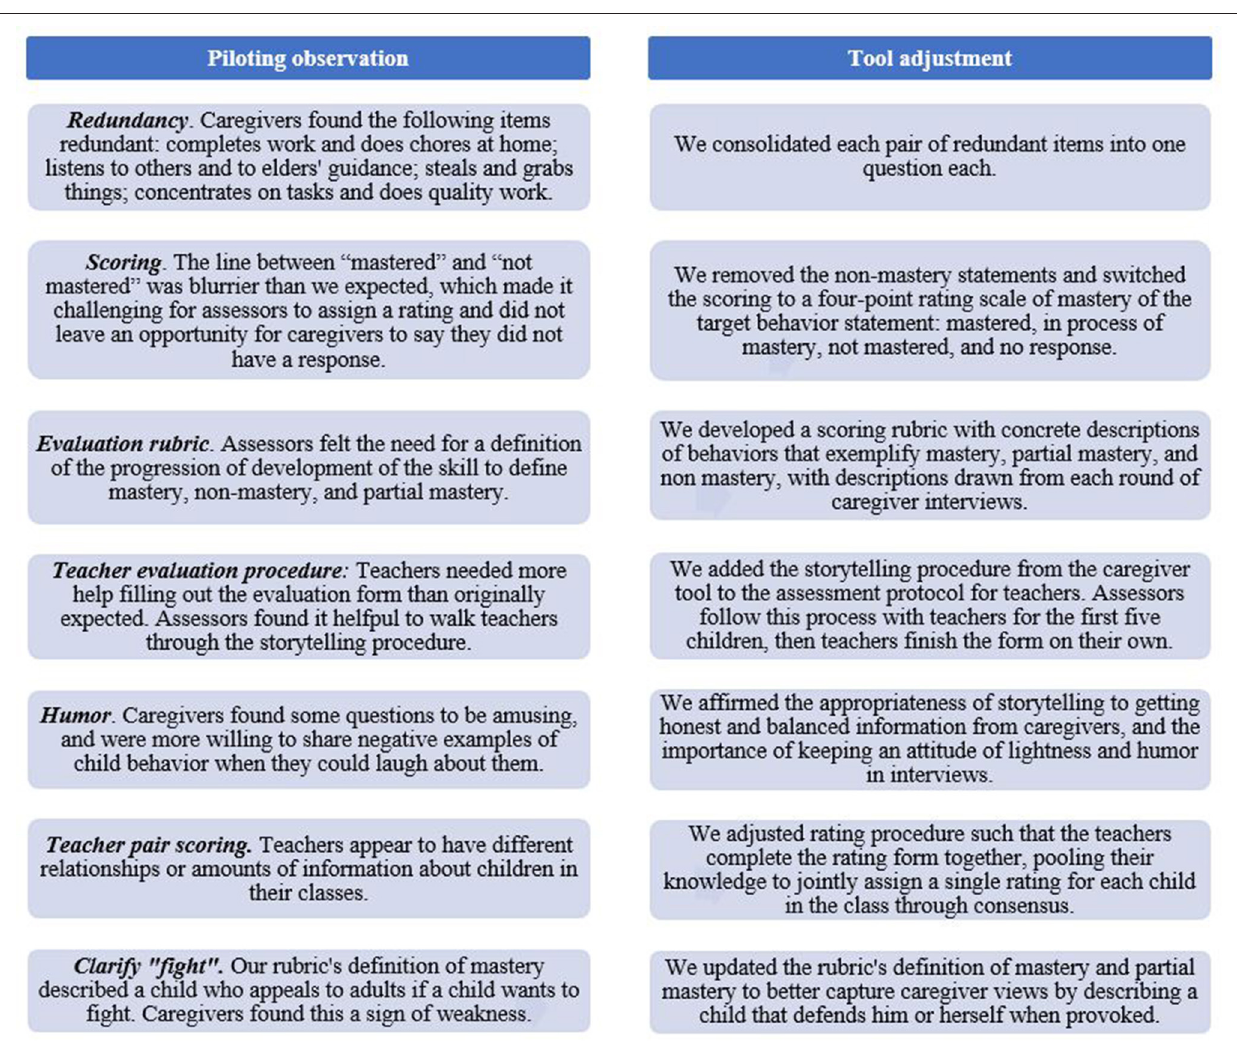
FIGURE 2 | Observations and adaptations to tools after initial